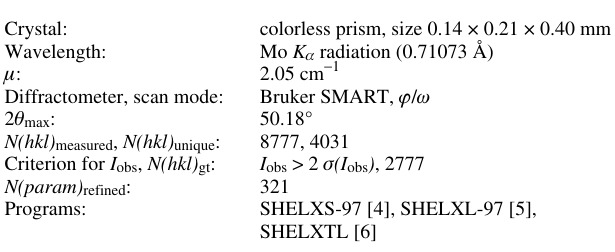
Table 1. Data collection and handling.